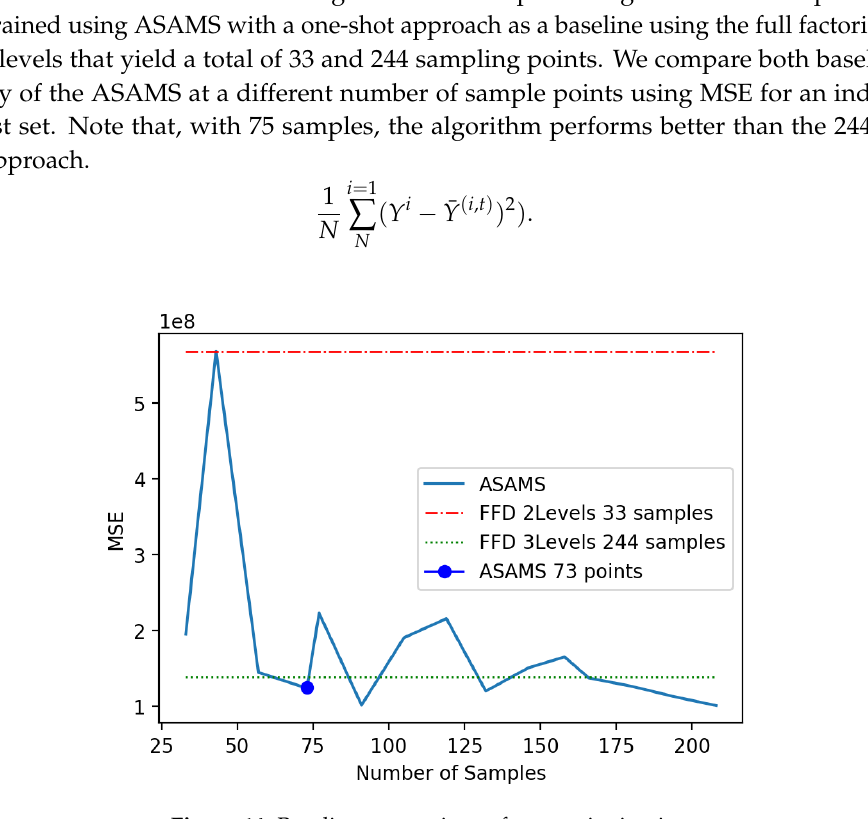
Figure 14. Baseline comparison of magnetic